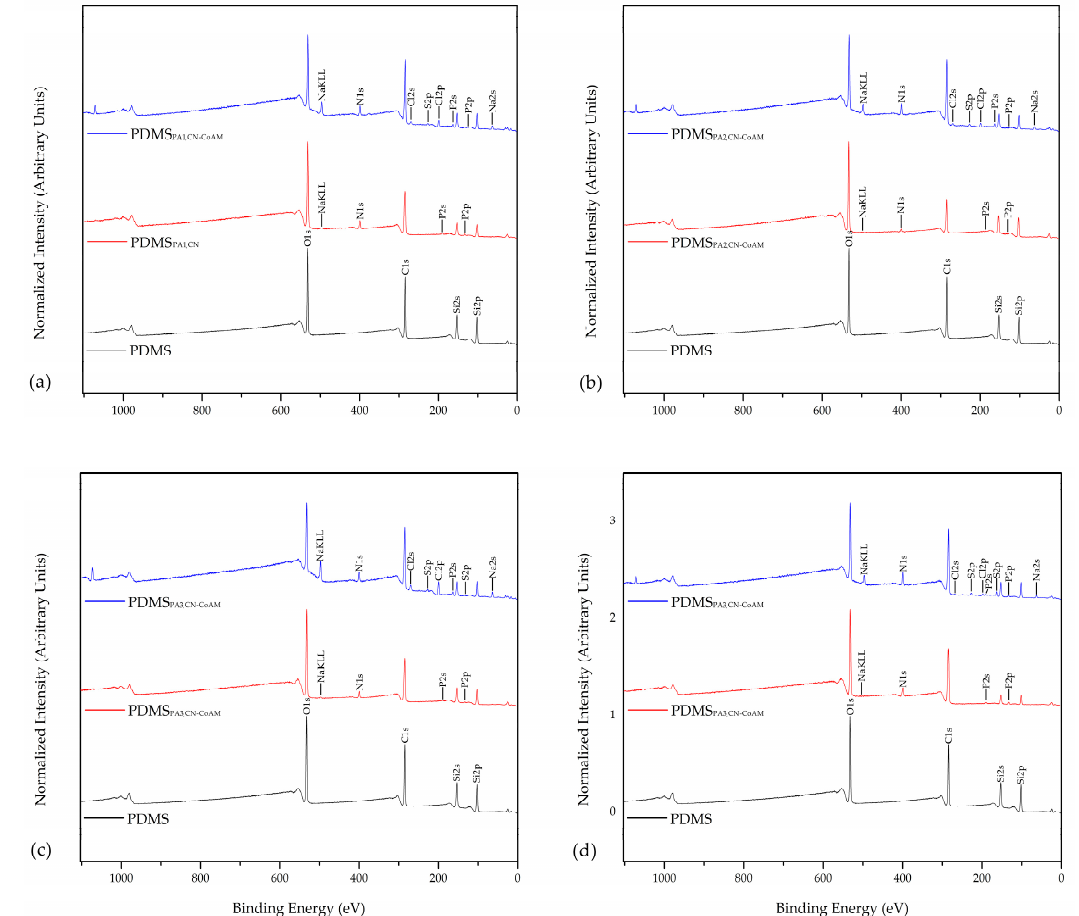
Figure 2. XPS analyses: Binding energy peaks of elements of O 2 plasma-activated silicone for 1 min ( a ), 2 min ( b ), 3 min ( c ) and 5 min ( d ), coated by chitosan nanoparticles alone or in combination with the drug.